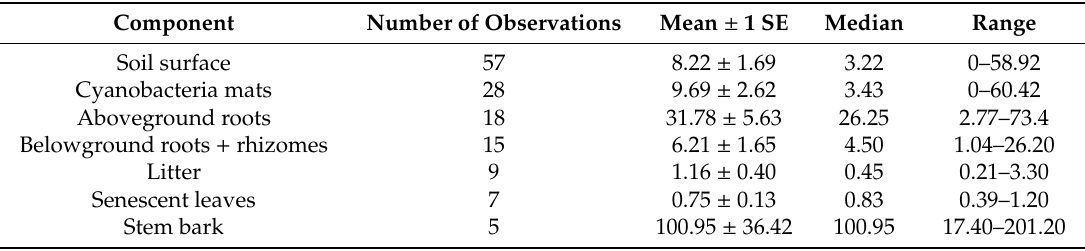
Table 2. Rates of nitrogen fixation (mg N m − 2 d − 1 ) at the mangrove soil surface, cyanobacteria mats, aboveground roots (pneumatophores and prop roots), belowground roots and rhizomes, litter and senescent leaves lying on the forest floor, and microbial crusts on the bark of tree stems [1,4,9,55–58, 129–161] and earlier references within. Rates presented on a g − 1 DW / WW basis were converted to m − 2 assuming 1 g matter = 1 cm − 3 . Ethylene rates were converted to N using the theoretical factor of 3 C 2 H 2 molecules = 1 N molecule